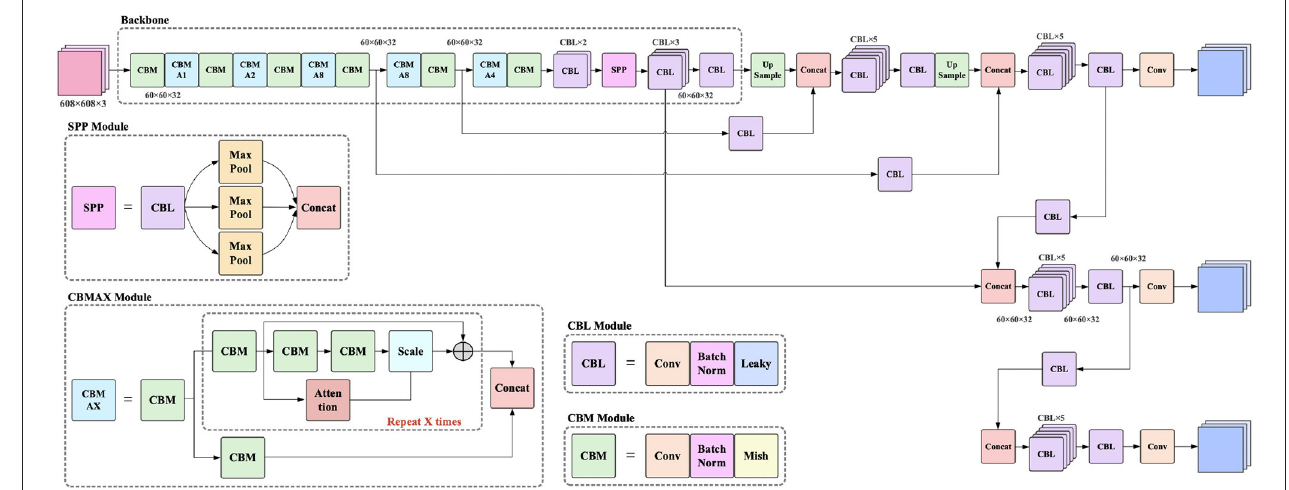
FIGURE 5 | Illustration of our